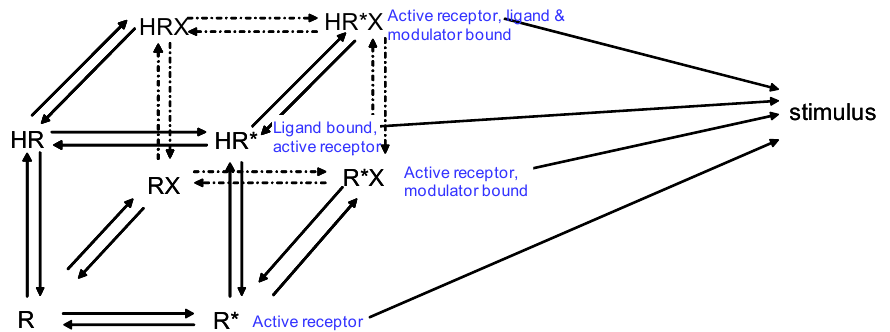
Figure 4. Allosteric two state model. R, inactive receptor; R*, active receptor; H, orthosteric ligand; X, allosteric modulator. Adapted from Hall et al .